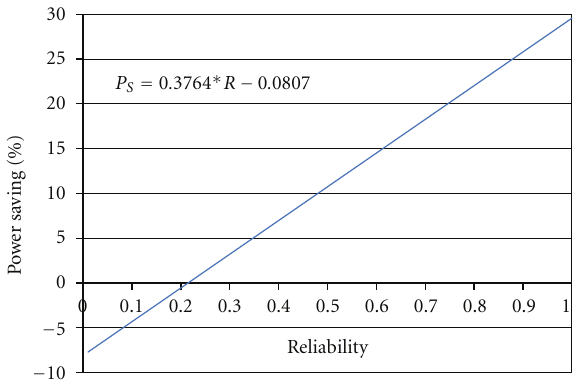
Figure 13: RARS power savings over